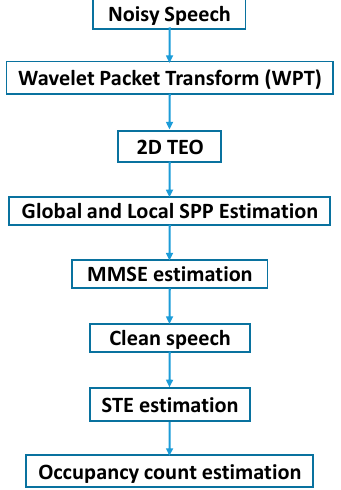
Figure 2. Flowchart of overall acoustic signal processing for occupancy count estimation.